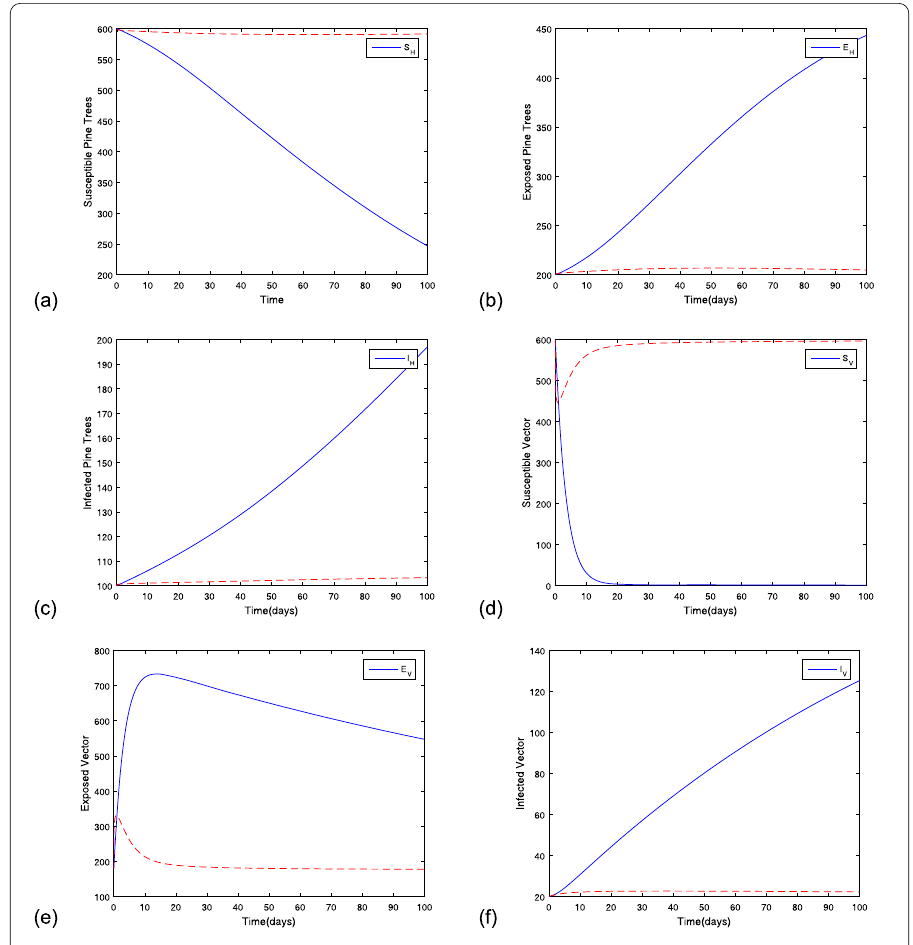
Figure 5 Simulations of pine tree population ( a )–( c ) and vector population ( d )–( f ) of the FPWD model (9) for τ = 0.2. ( a ): Susceptible pine tree; ( b ): Exposed pine tree; ( c ): Infected pine tree; ( d ): Susceptible vector; ( e ): Exposed vector; ( f ): Infected